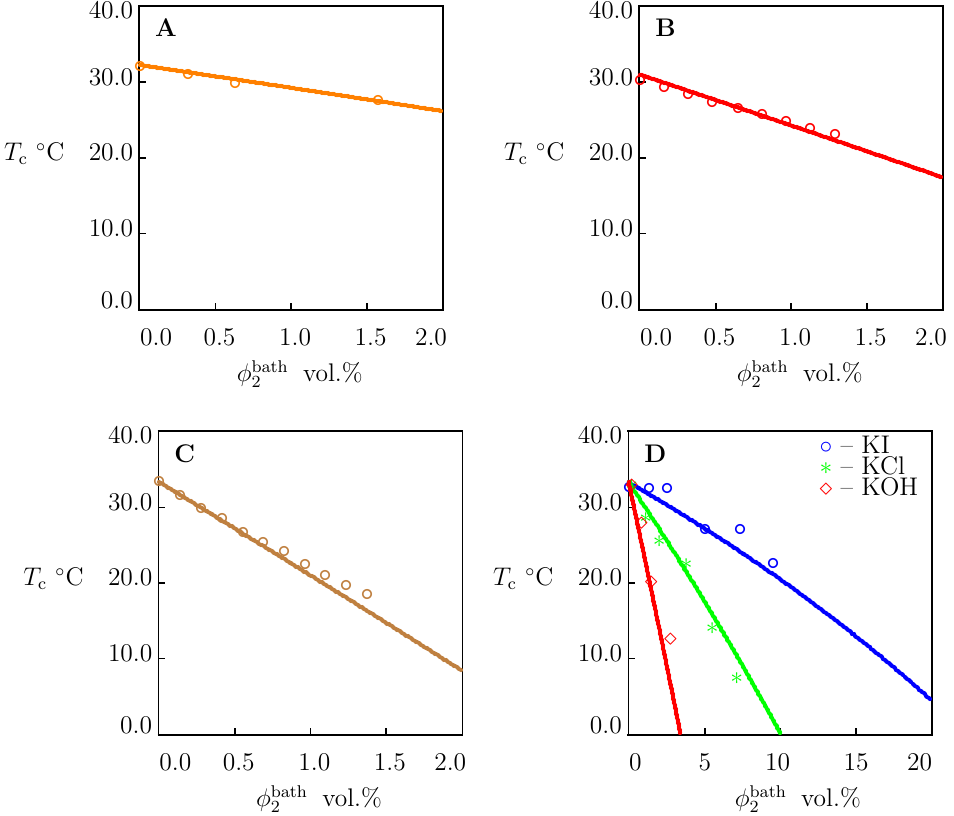
Figure 9. The critical temperature T c versus concentrations of additives in aqueous solutions φ bath Circles: experimental data on PNIPAAm chains. ( A )—NaBr [46], ( B )—NaF [7], ( C )—Na 2 CO 3 [47], ( D )—KI, KCl, KOH [48]. Solid lines: predictions of the